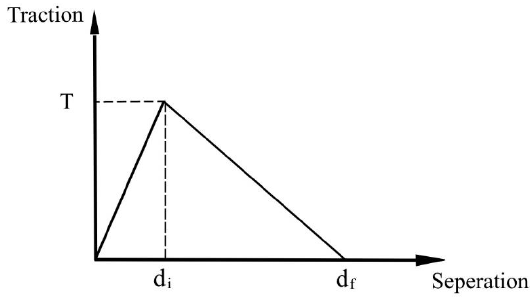
12 of 25 Figure 13. Grid diagram. 3.3. Contact Models and Boundary Conditions